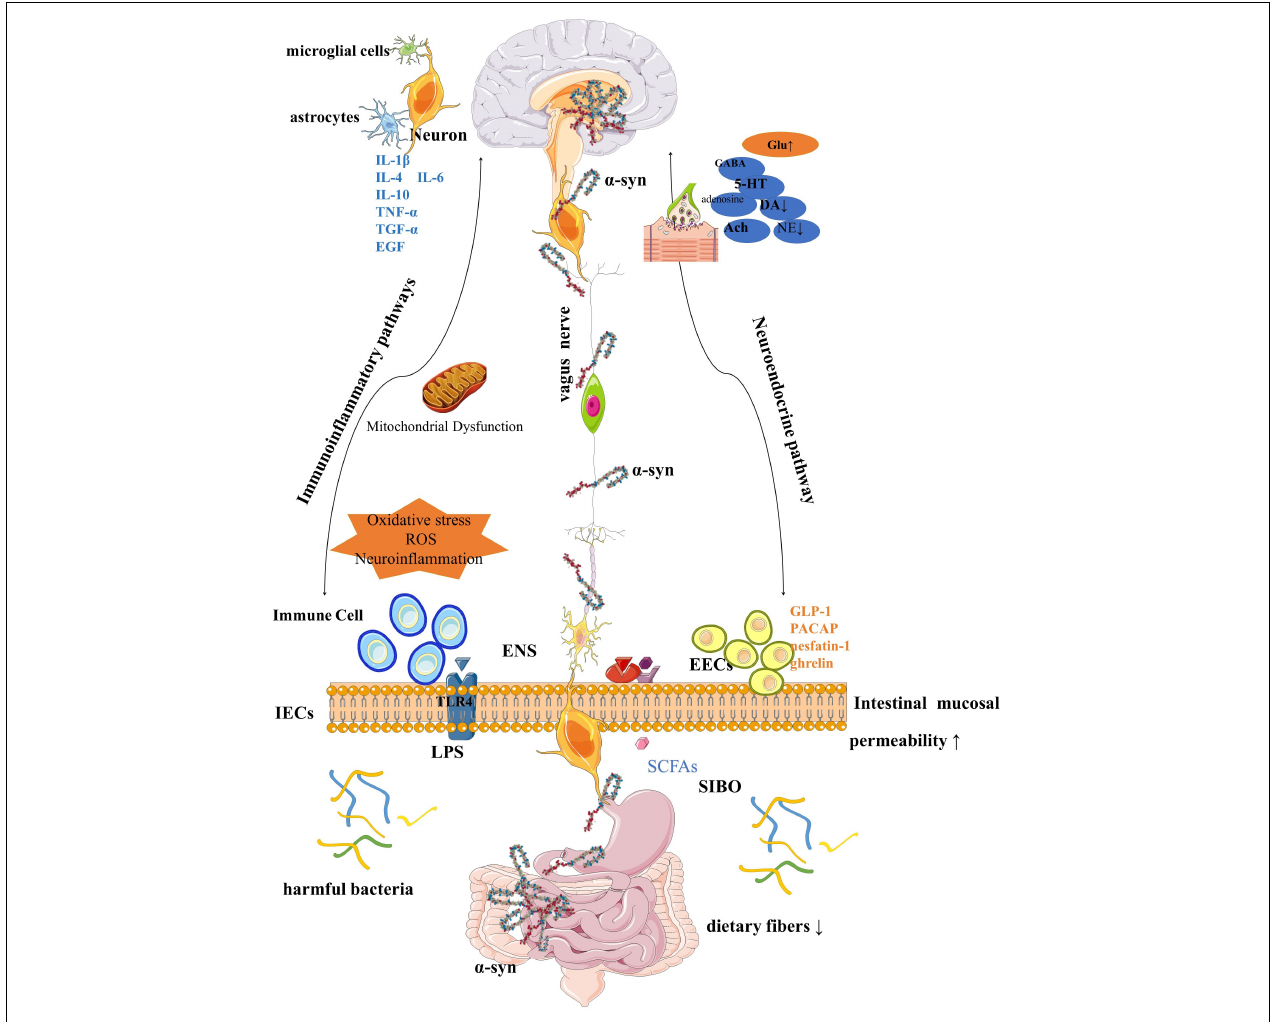
FIGURE 4 | Gut-brain axial pattern